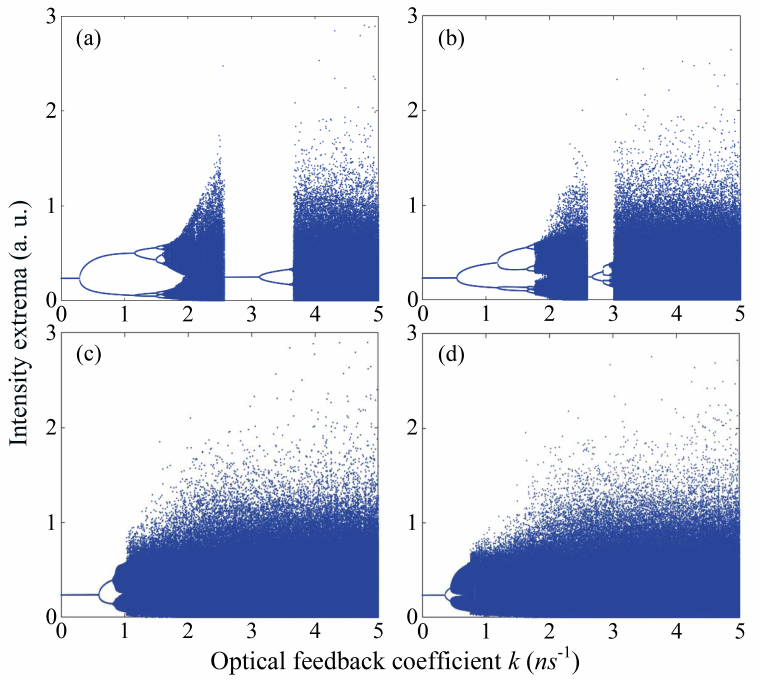
Figure 2. Bifurcation diagrams of the RCP intensity extrema versus optical feedback coefficient k : ( a )